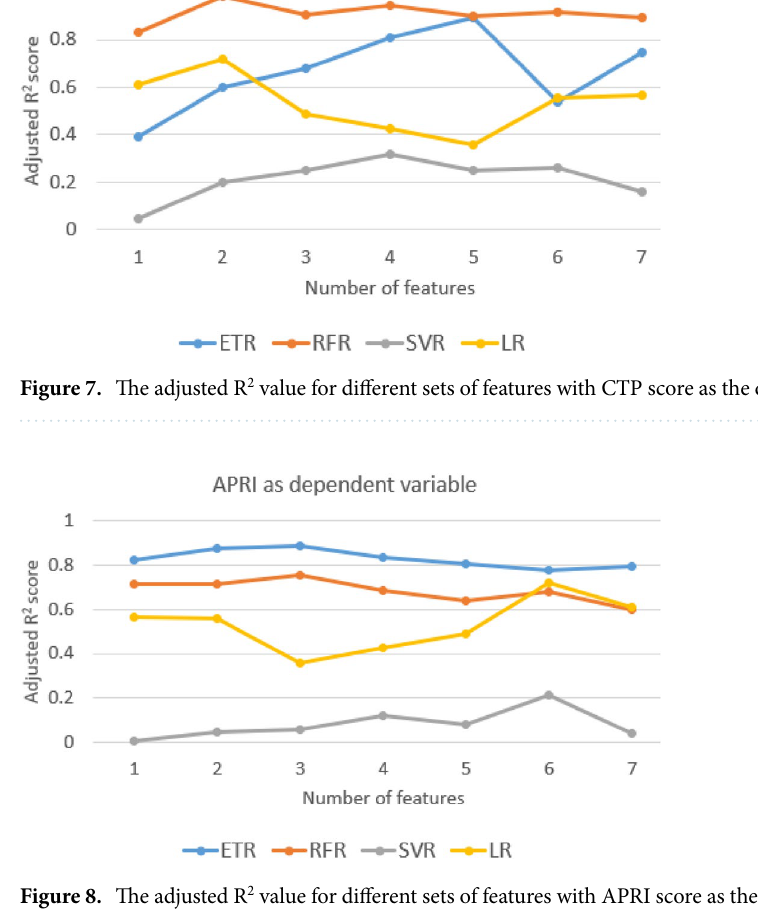
Figure 8. The adjusted R 2 value for different sets of features with APRI score as the dependent variable.